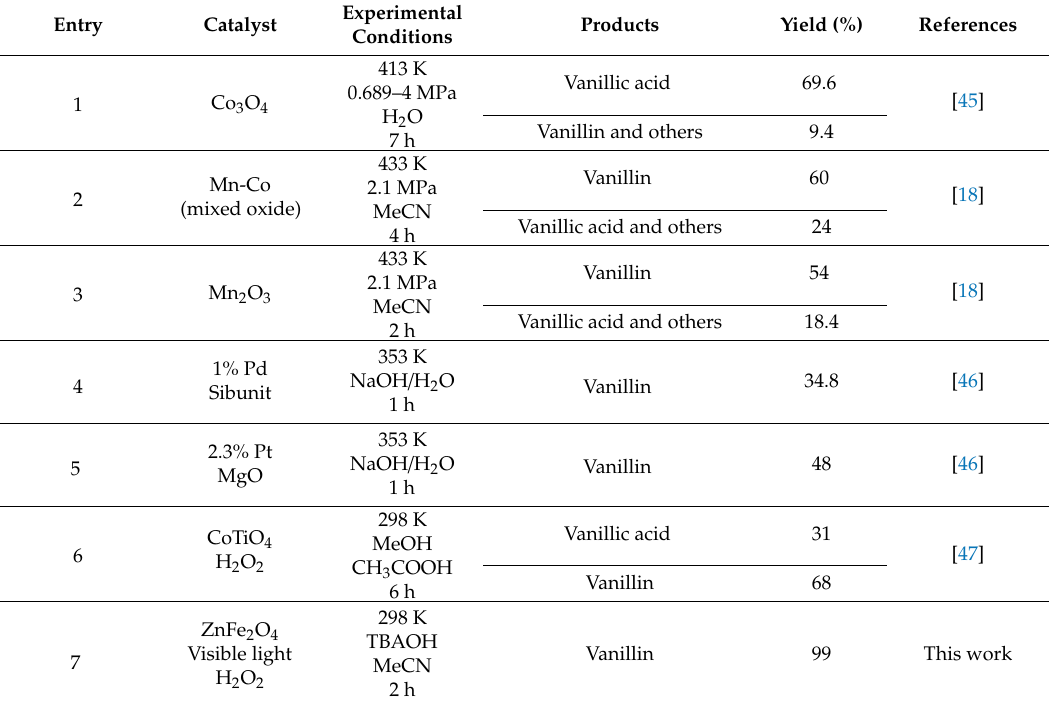
Table 2. Oxidation of VAL using a heterogeneous catalyst.